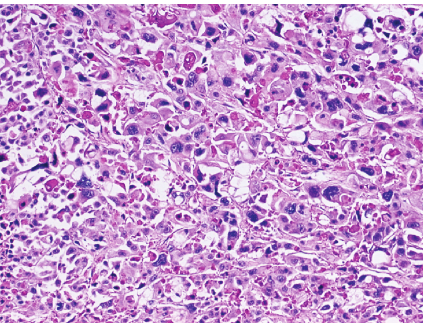
Figure 6: Lymphadenopathy along entire length of aorta by tumor.